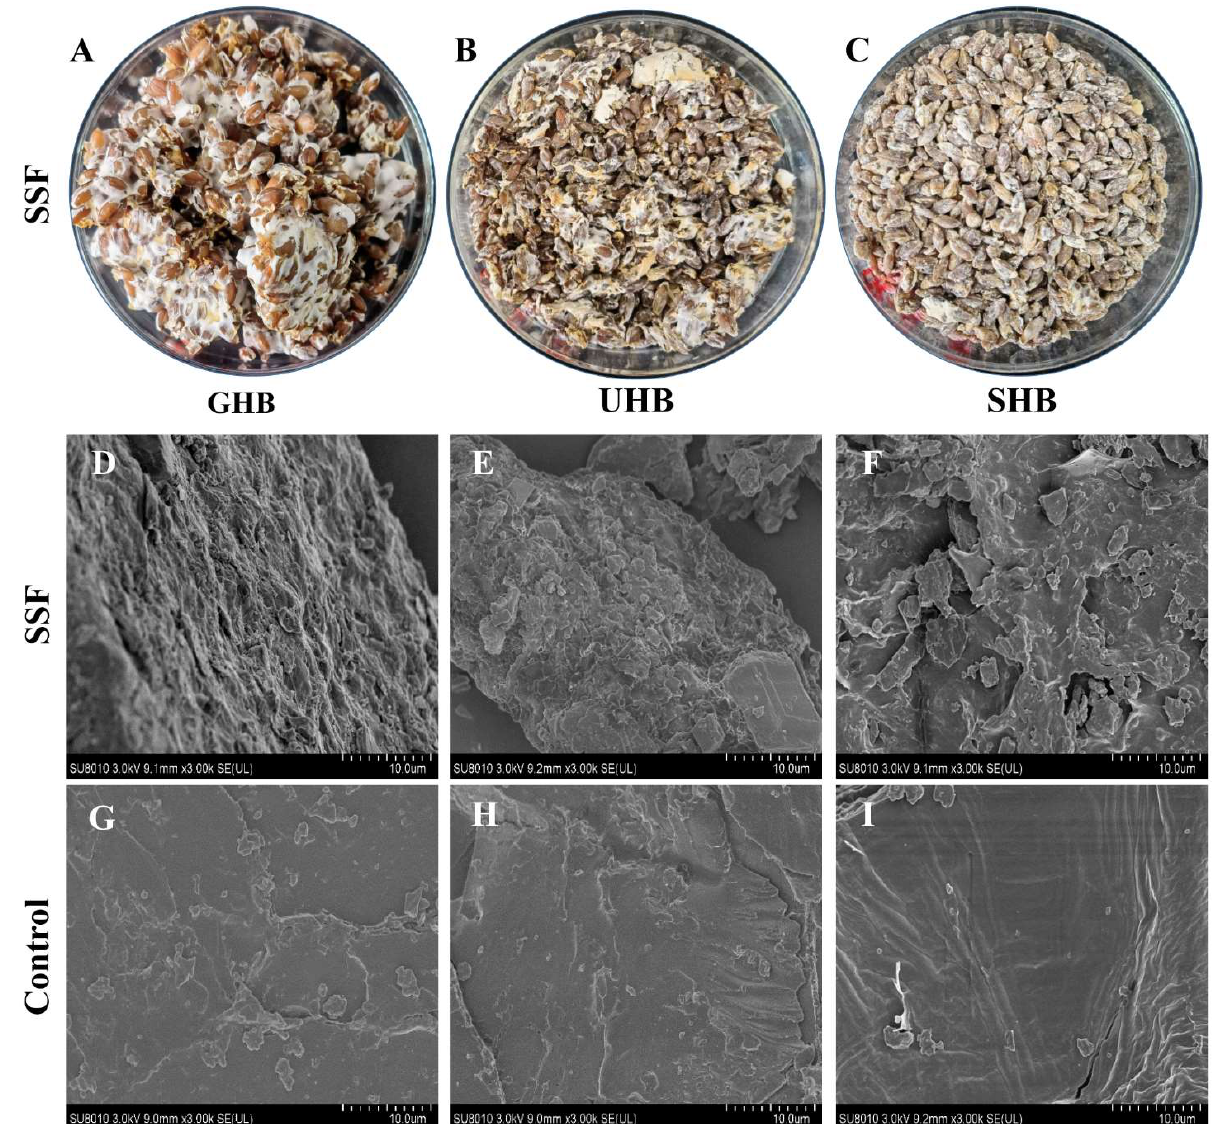
Figure 1. Appearance of solid-state fermentation highland barley. The letter ( A – C ) represents solid-state fermentation HB treated by germination (SSF-GHB), ultrasound (SSF-UHB), and soaking (SSF-SHB), respectively. Scanning electron microscopy of solid-state fermented and control highland barley. ( D – F ) indicate solid-state fermentation HB treated by germination (SSF-GHB), ultrasound (SSF-UHB), and soaking (SSF-SHB), respectively. ( G – I ) indicate germinated, sonicated, and soaked HB for control groups (GHB, UHB, SHB),